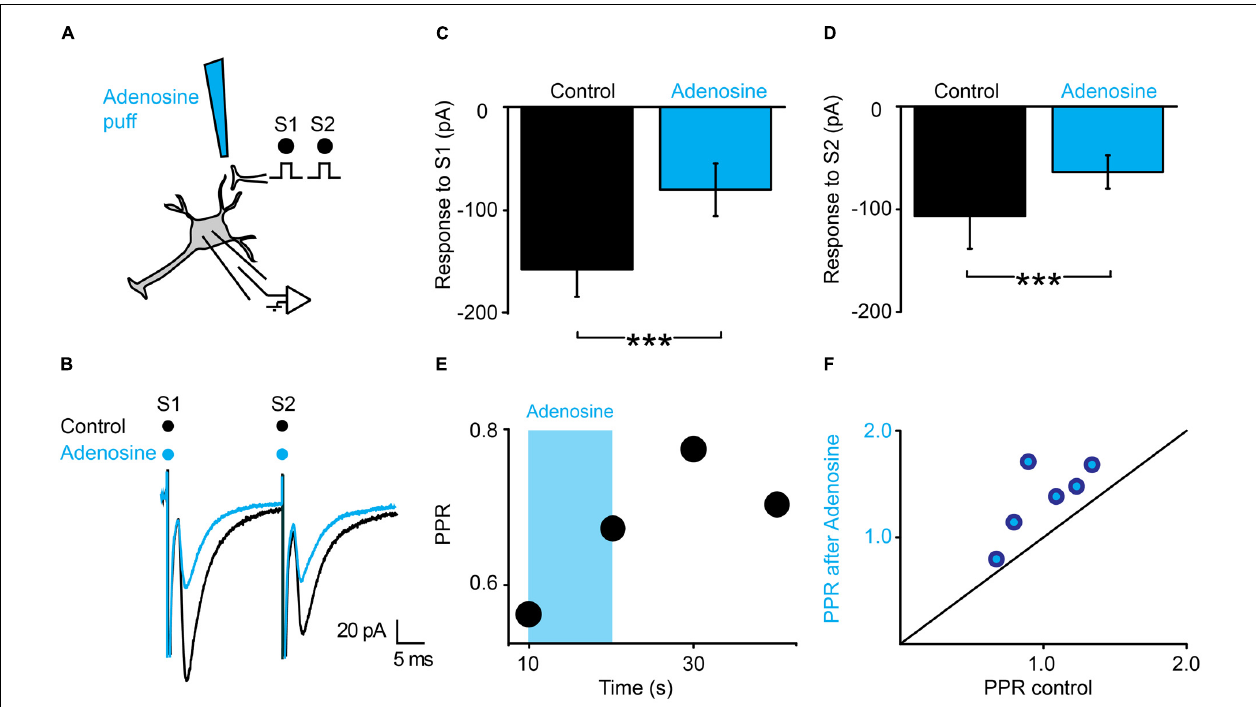
FIGURE 5 |Adenosine generates presynaptic inhibition. (A) Schema of the principle of the preparation. Ventral horn neuron recorded in whole-cell mode. Synaptic stimulation produced by a bipolar electrode (S1, S2). Puff application of adenosine. (B) Response of a ventral horn neuron to two stimulations in control conditions (black) and after puffing adenosine between the stimulation and recording electrode (blue). The amplitude of both EPSCs was decreased. (C) Amplitude of the first